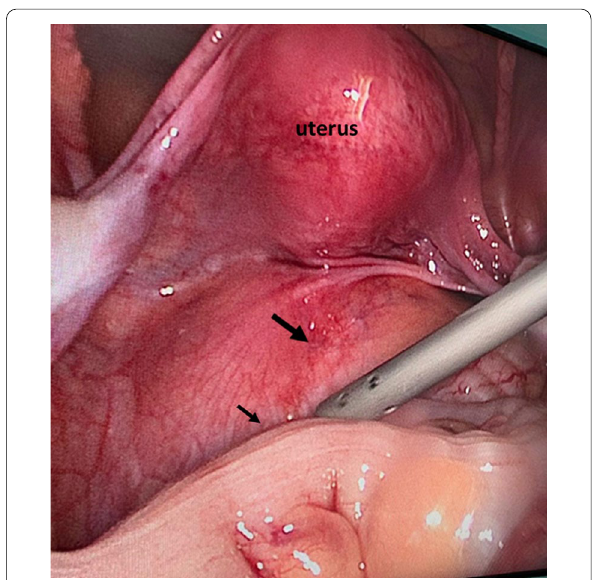
Fig. 2 Intra-operative fining of Sacrococcygeal mass (long arrow) pushing the rectum (short arrow) anteriorly to the right